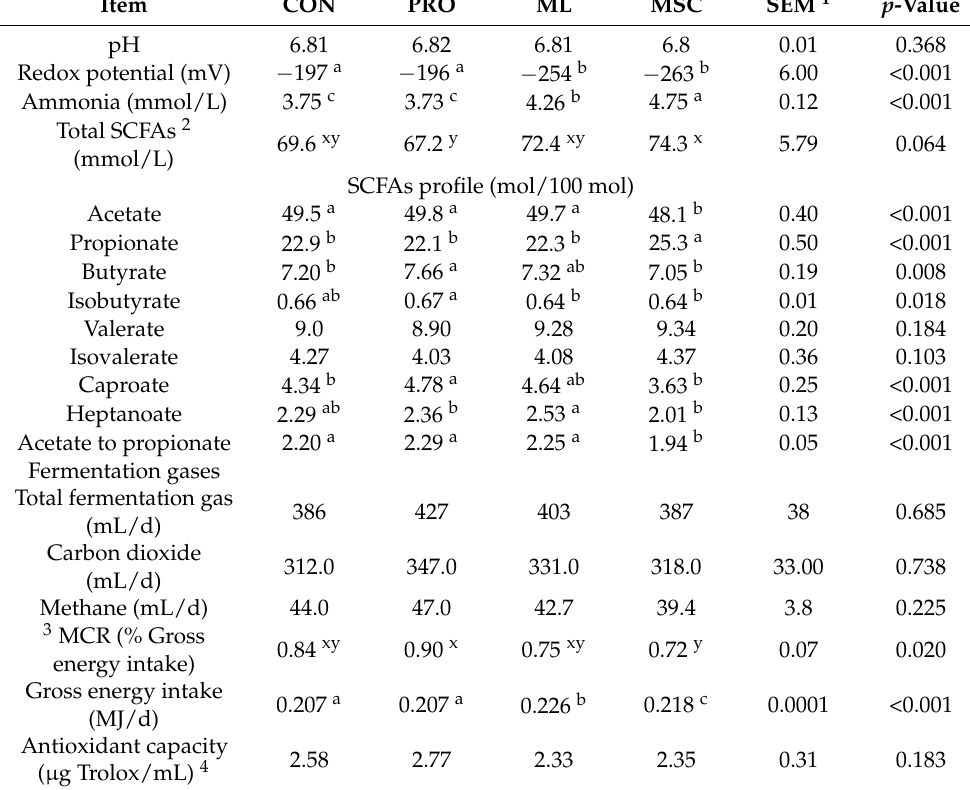
Table 3. Ruminal fermentation parameters as affected by dietary treatments *.